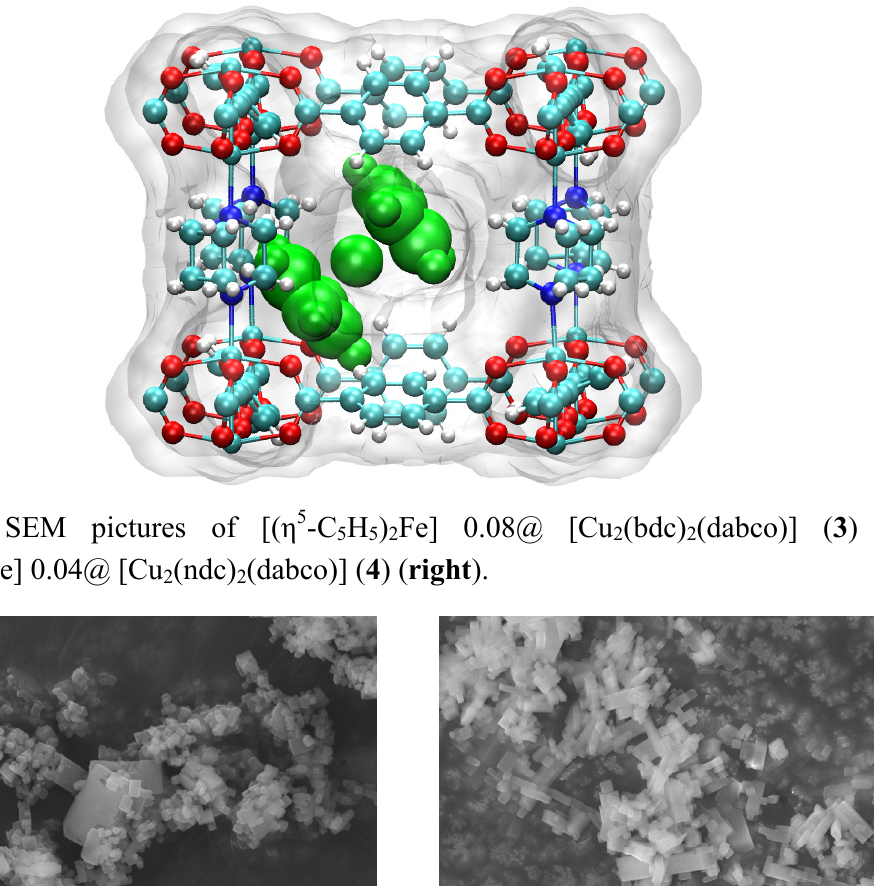
Figure 2. Geometry of [Cu (bdc) (dabco)] ( 1 ) after the embedding of one molecule of 2 2 ferrocene per unit cell, as obtained from MD-simulations. The grey surface indicates the free space in the unit cell of the empty MOF before the loading process. White: hydrogen, teal: carbon, red: oxygen, purple: nitrogen, teal: copper, green: Ferrocene.